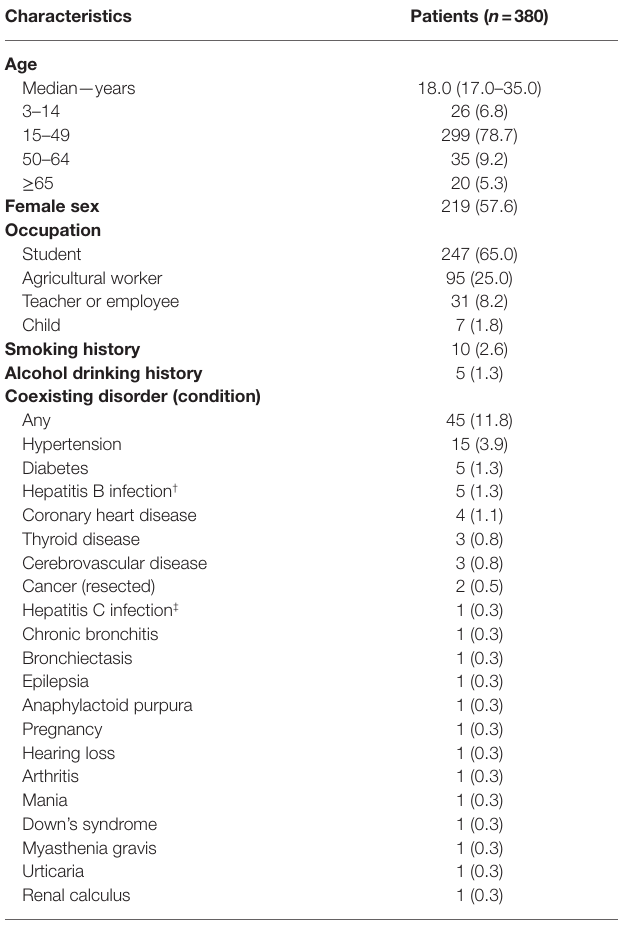
TABLE 2 | Demographic characteristics of patients on